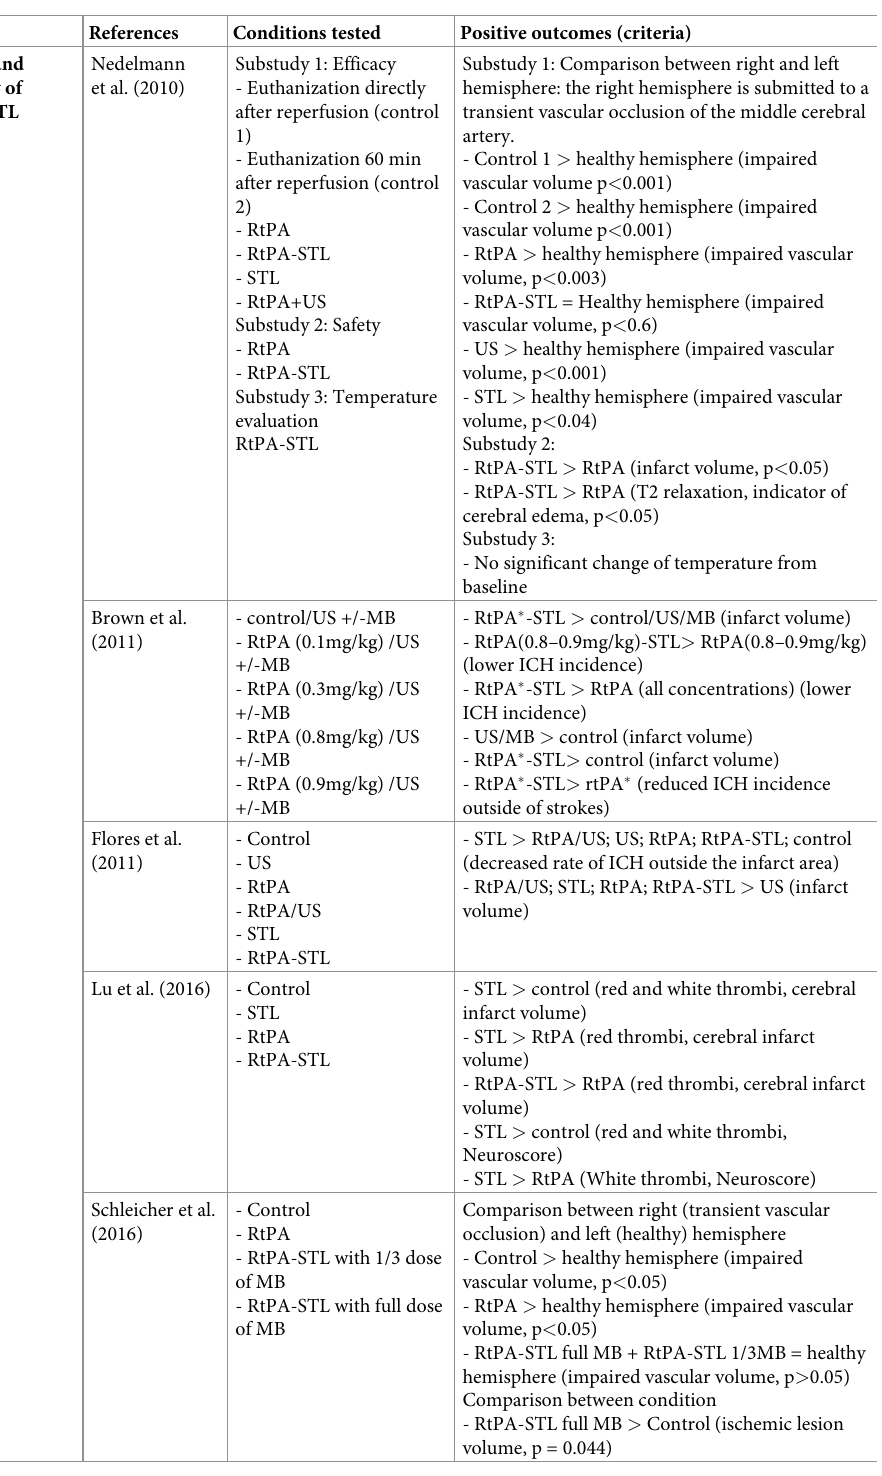
Substudy 1: Comparison between right and left hemisphere: the right hemisphere is submitted to a transient vascular occlusion of the middle cerebral